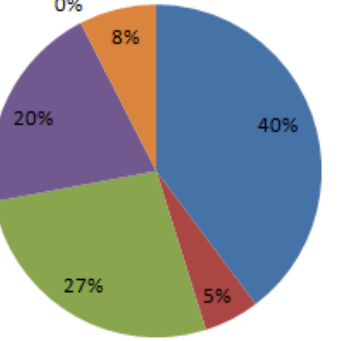
Figure 10. Justifications for EU polity worth (n = 258).